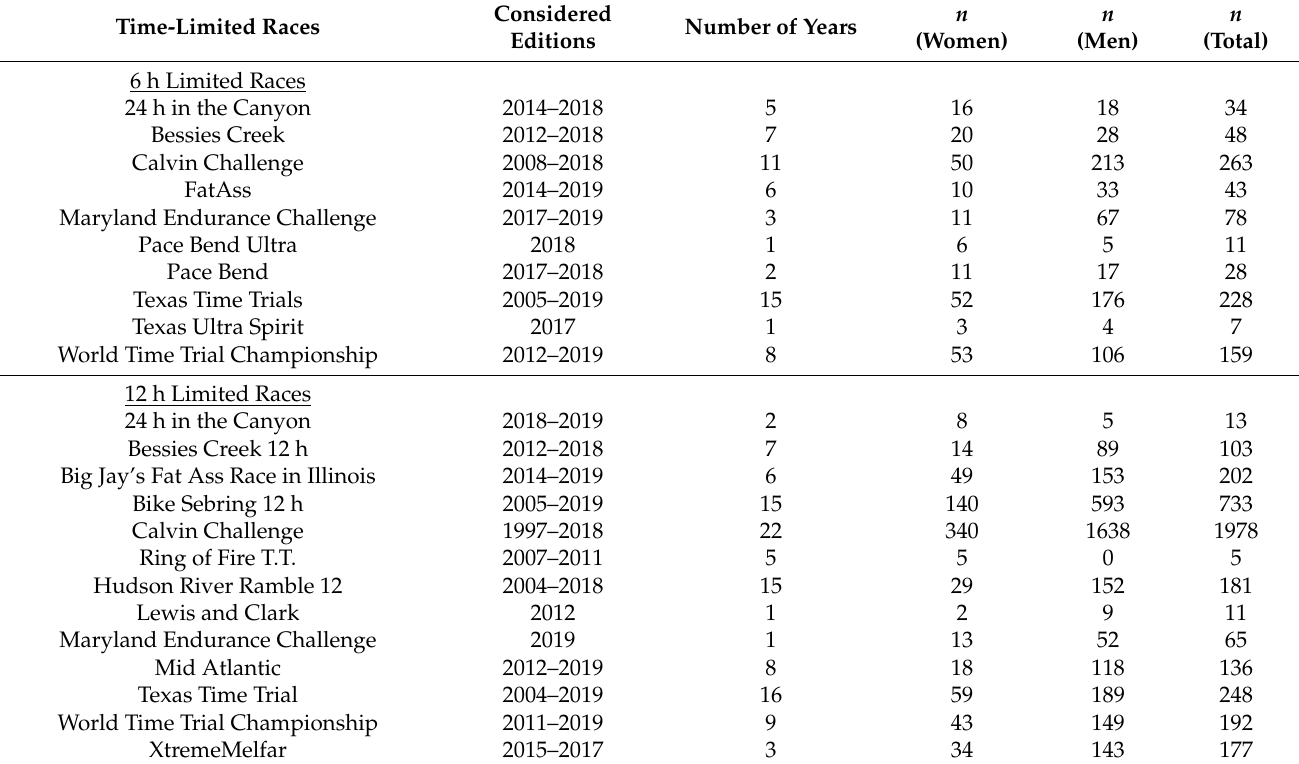
Table 1. All included time-limited ultra-cycling